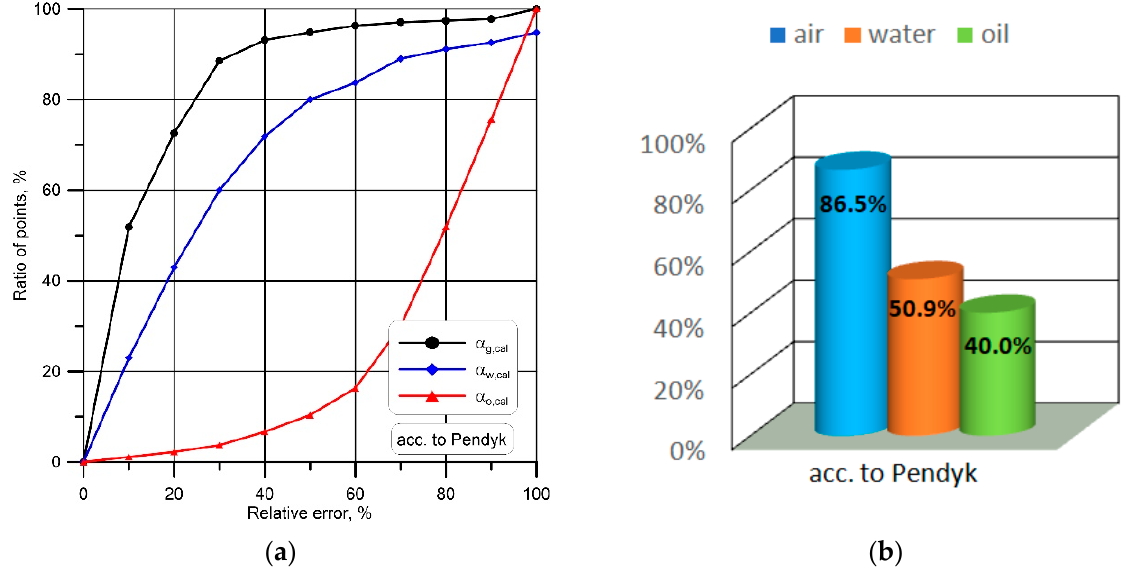
Figure 8. Statistical analysis of method applied for determining void and volume fraction of phases for downward three-phase oil–water–air flow ( a ), and ( b ) values of experimental points located within the range of <30% of the MAE of experimental points, in accordance with the Pendyk method [45].